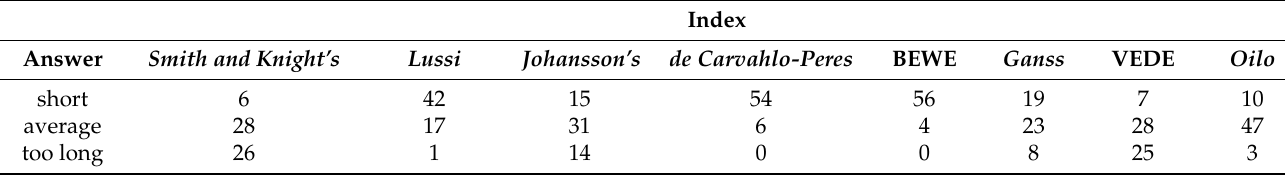
Table 6. Answers of the operator regarding the time needed to calculate a particular